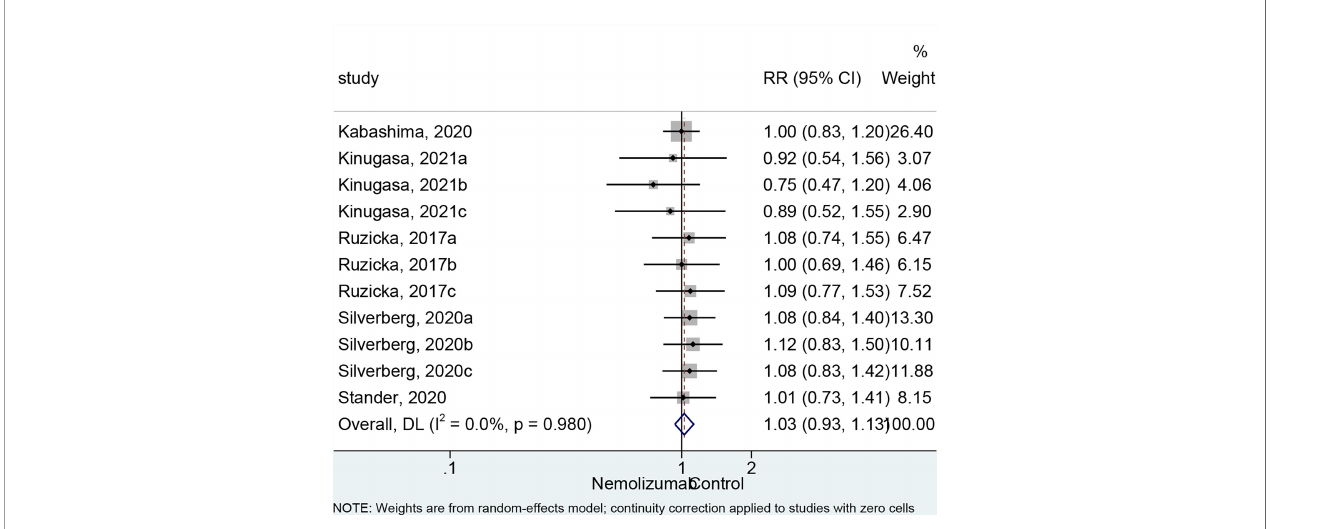
Supplementary Figure 1 | (A) Forest plot of pruritus visual analog scale comparing nemolizumab and placebo by the frequency of injection. (B) Forest plot of Eczema Area and Severity Index comparing nemolizumab and placebo by the frequency of injection. (C) Forest plot of adverse events comparing nemolizumab and placebo by the frequency of injection. Supplementary Figure 2 | (A) Sensitivity analysis of pruritus visual analog scale. (B) Sensitivity analysis of Eczema Area and Severity Index. (C) Sensitivity analysis of adverse events Supplementary Figure 3 | (A) Funnel plots for pruritus visual analog scale. (B) Funnel plots for adverse events.